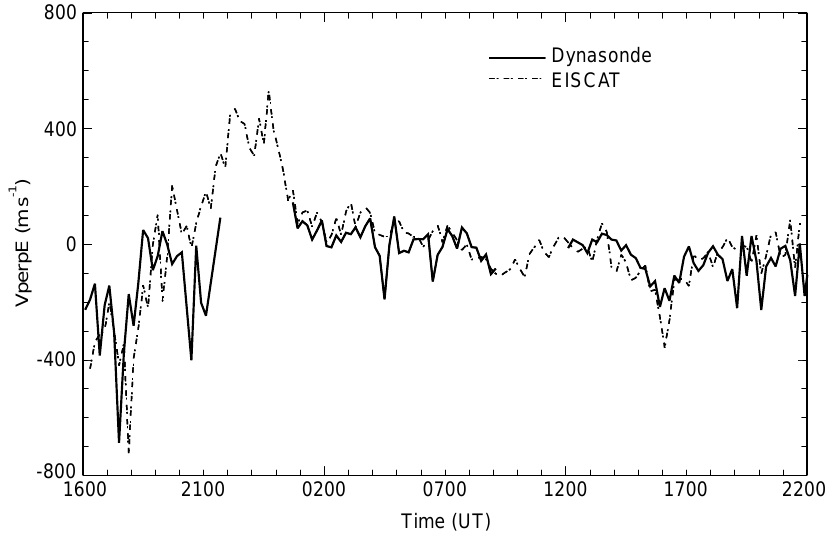
Fig. 6. Time series of EISCAT and Dynasonde F -region velocities from the experiment CP-1-K, 8 — 9 June 1994. The eastward component of plasma velocity perpendicular to the geomagnetic field line is shown. Both curves are 12 min running